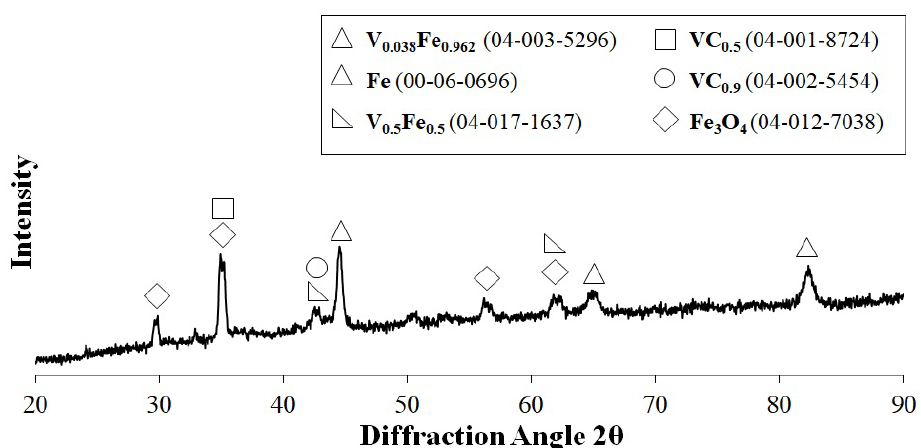
Figure 7. XRD analysis of vanadium coating produced using a laser beam power of 900 W.